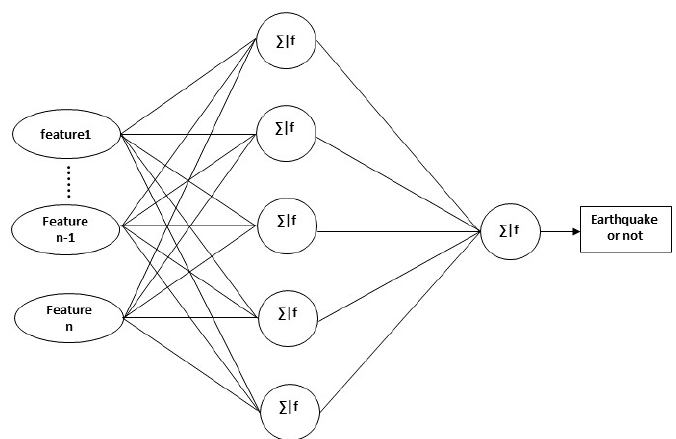
Figure 6. The general structure of the ANN